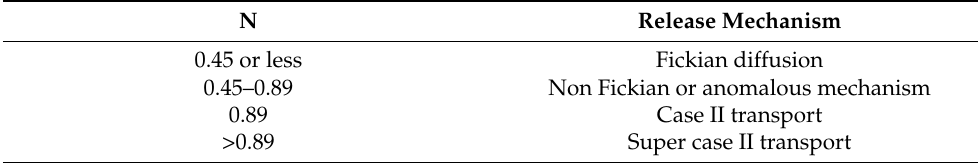
Table 2. Relationship of n value with release mechanism.